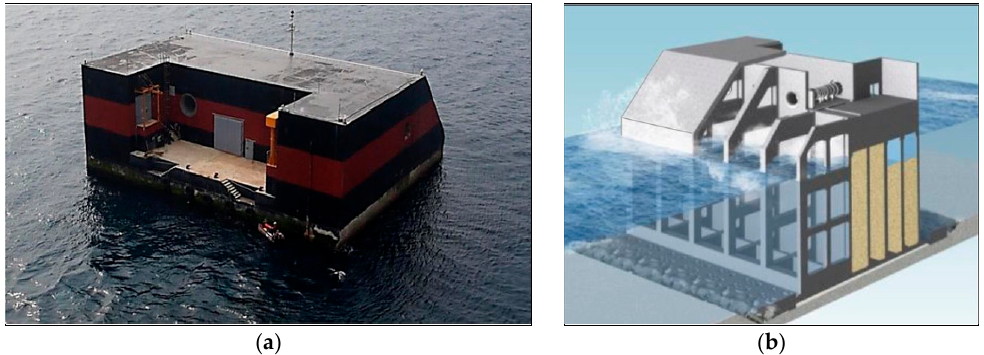
Figure 9. 500 kW bottom-standing plant at Yongsoo, Jeju Island, South Korea. ( a ) back view. ( b ) perspective section